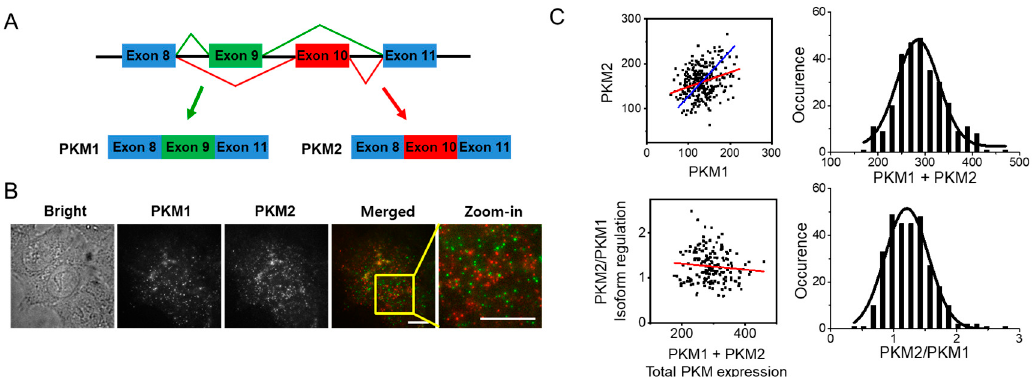
Figure 1. Detection of endogenous mRNAs of PKM isoforms in HCT116 cells using SM-FISH-STIC. ( A ) Schematic diagram of alternative splicing of PKM isoforms. PKM1 and PKM2 are produced via alternative splicing of the mutually exclusive exons 9 and 10. ( B ) Fluorescence images of single PKM mRNAs in HCT116 cells. PKM1 was detected with AX488 (green), and PKM2 was detected with Cy3. Images were processed as described in the Materials and Methods section and visualized using a maximum intensity projection of the entire z -axis of the cells (20 µ m). Scale bar, 10 µ m. ( C ) ( Left ) 2D plot of PKM isoforms in HCT116 cells. Each point corresponds to the number of mRNA molecules of each PKM isoform in individual cells. A linear regression of all the points is shown as a red line. The slope of the blue line corresponds to 1.2 (the average ratio of PKM2 to PKM1), and it passes through the average value of each PKM isoform (132, 159). ( Right ) Distribution of the total number of PKM isoform molecules ( top ) and the relative ratio of PKM2 to PKM1 ( bottom ) in individual